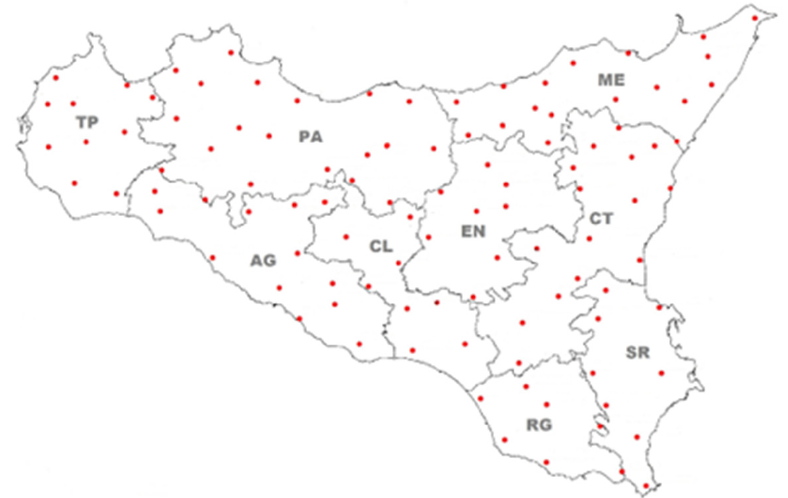
Figure 1. Location of weather stations (red dots).